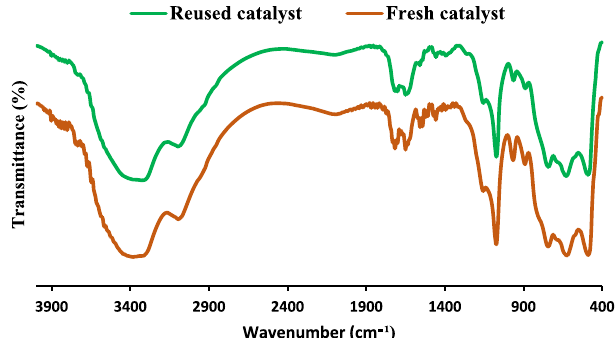
Figure 9. Comparison of the FTIR spectra of fresh and reused B-V-PIL/W after 5 runs of the model alcohol oxidation reaction.